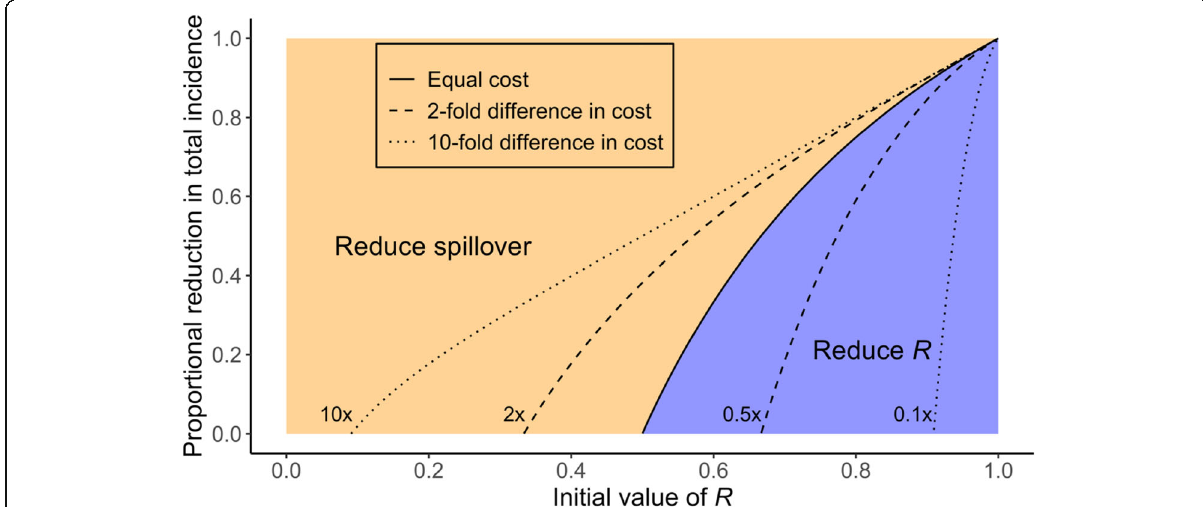
Fig. 5 Policy guidance whether incidence will be reduced more by focusing on reducing spillover transmission or human-to-human transmission, for different values of R (before control) and the reduction in spillover that is achievable given resource constraints. The solid line shows the boundary between preferred strategies when costs of the two types of control are equal, as defined by Eq. (5). The dashed and dotted lines show how the boundary shifts due to differences in relative cost (each line is labeled by the relative cost of reducing spillover by a given proportion compared to the cost of reducing R by the same